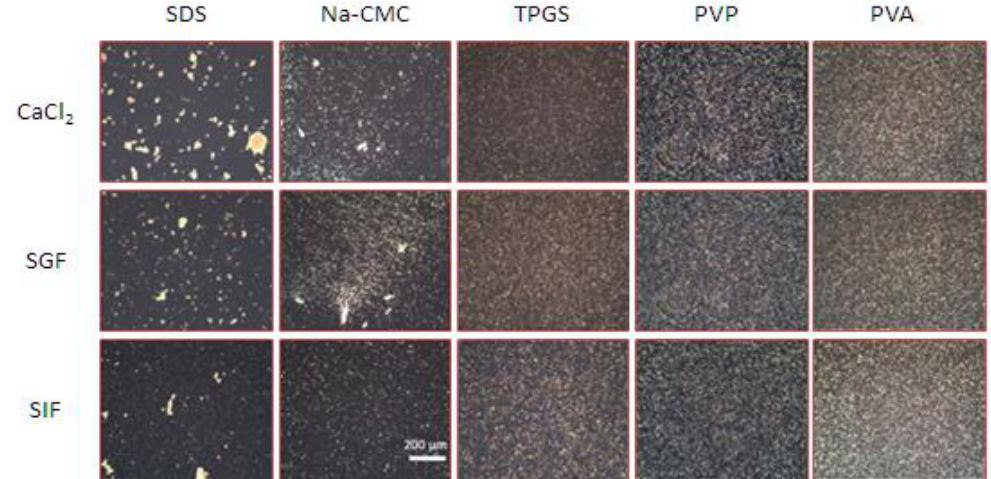
Figure 3. Polarized microscopy images of curcumin nanosuspension after incubation with electrolytes